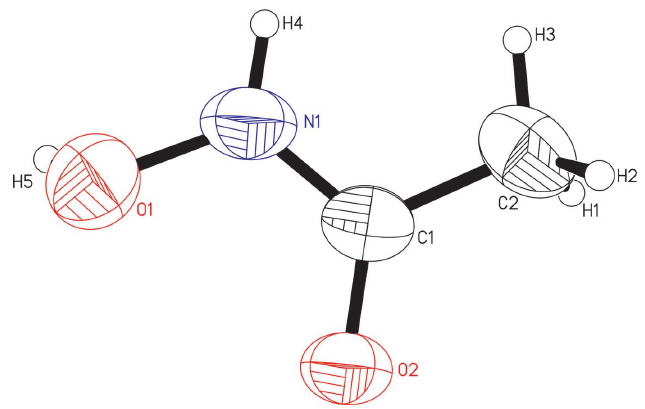
Figure 1 The molecular structure of the title compound, with displacement ellipsoids drawn at the 50% probability